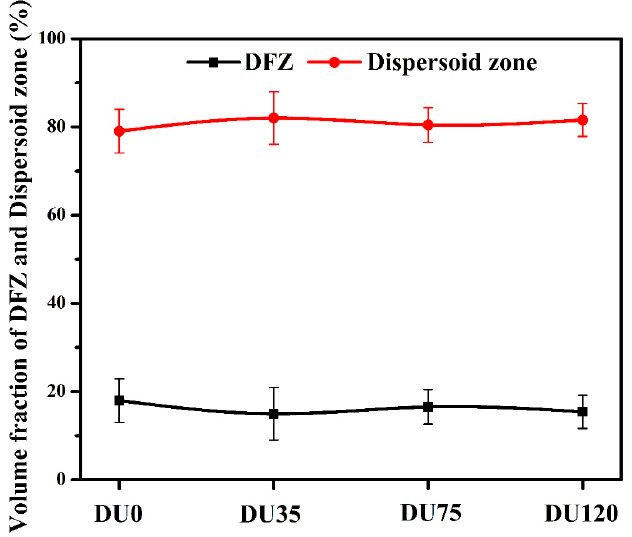
Figure 5. The volume fractions of the dispersoid zones and dispersoid free zones (DFZ) in the experimental alloys.